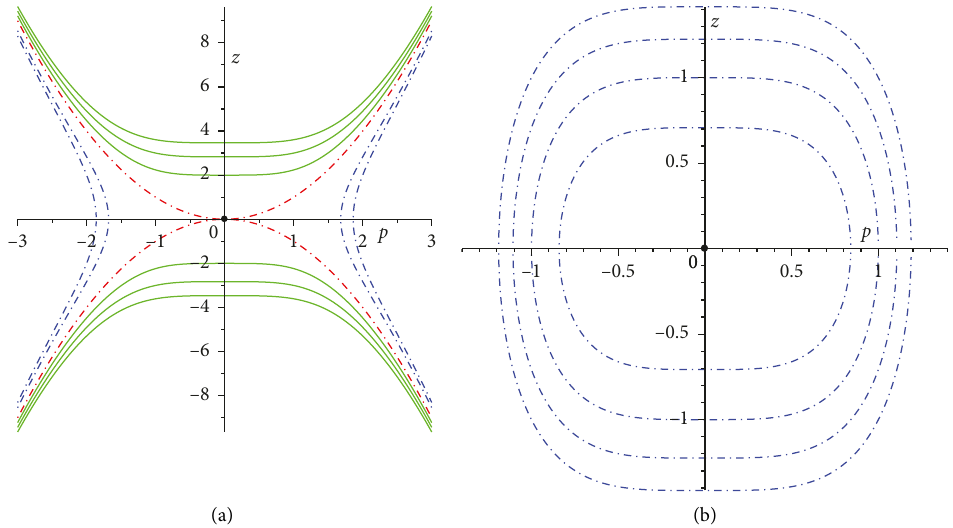
Figure 1: Phase portrait for the Hamilton system (43) for c